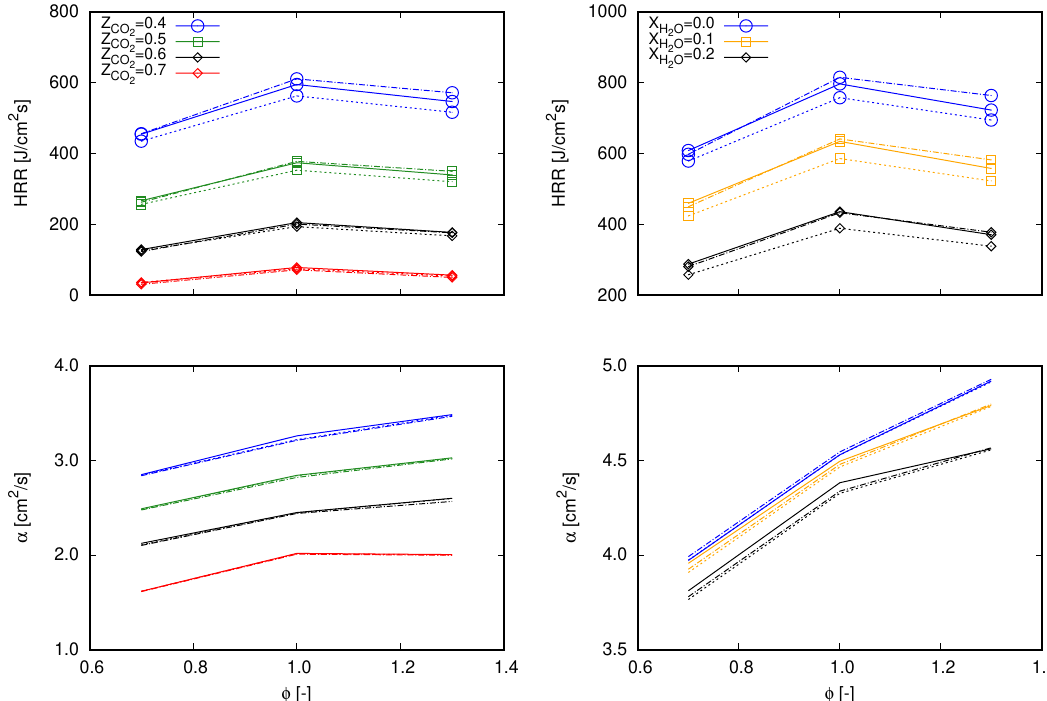
Figure 3. Values of computational domain ( HRR ) (lines with marks) and α (lines without marks) for φ = 0.7, 1.0, and 1.3 computed with different mechanisms. Continuous lines, GRI 3.0; dashed lines, DTU; dash-dot lines, CRECK C1-C3. ( left ) CO 2 dilution; and ( right ) H 2 O